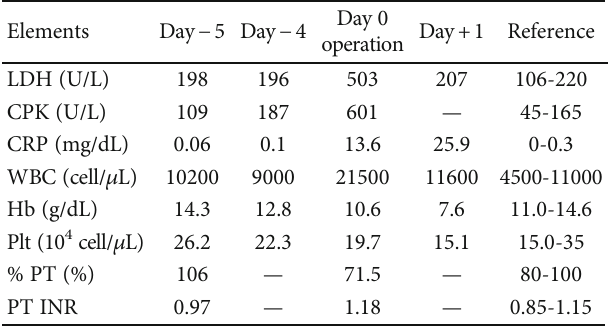
Table 1: Laboratory fi